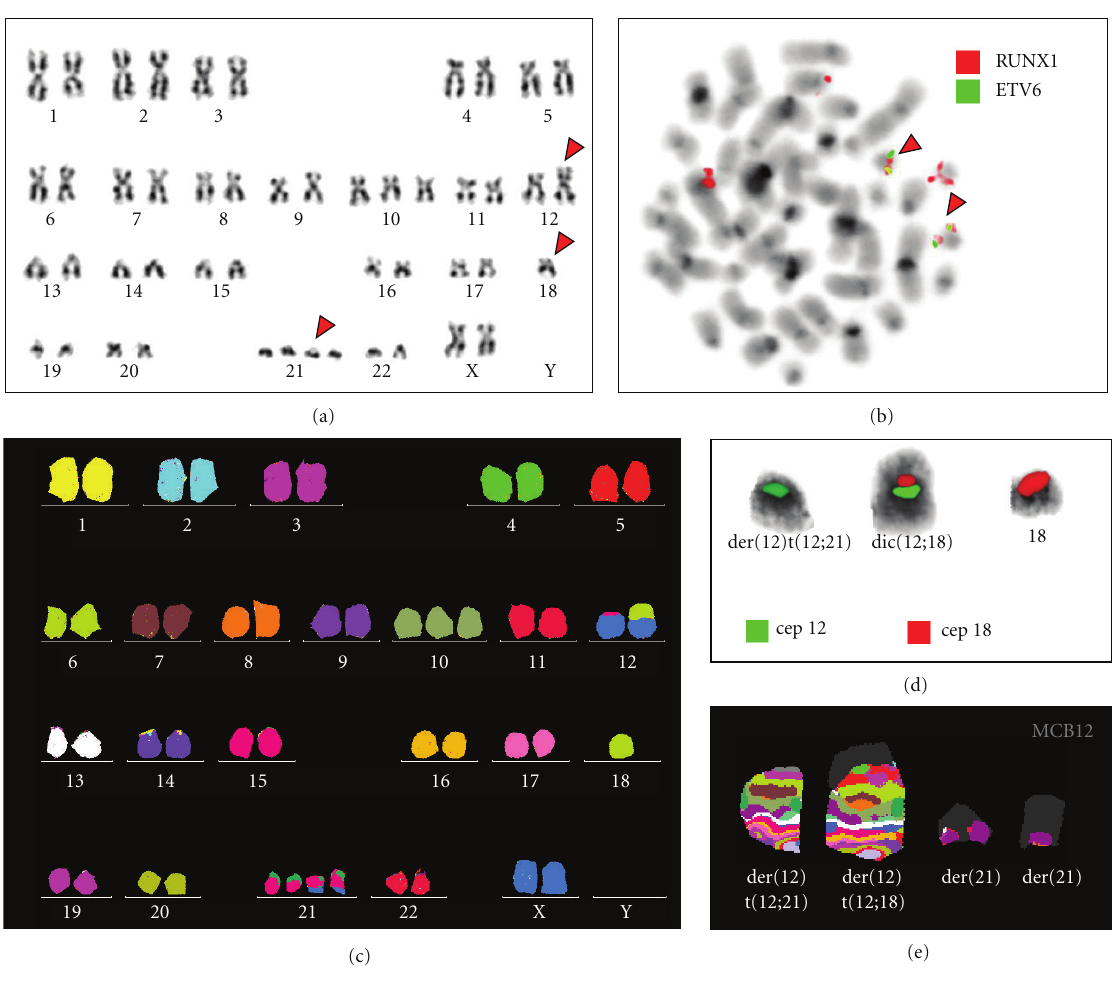
Figure 1: Conventional and molecular cytogenetics dates. (a) G-banding. The arrows show add (12p), − 18, and +21, +21; (b) FISH shows two copies of der(21)t(12;21) (arrows), two 21 chromosomes, and ETV6 deletion; (c) M-FISH showing the 10 trisomy and der(12)t(12;21); dic(12;18)(p12;q11.21), der(21)t(12;21), +21; (d) CEP probe 12 and 18 shows dic(12;18); (e) MCB: showing the breakpoints of the der(12)t(12;21) and